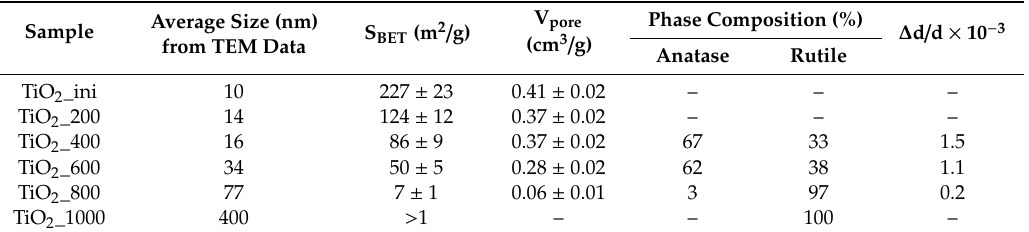
Table 1. Nanoparticles’ (NPs’) size, BET, and X-ray di ff raction (XRD) data for the